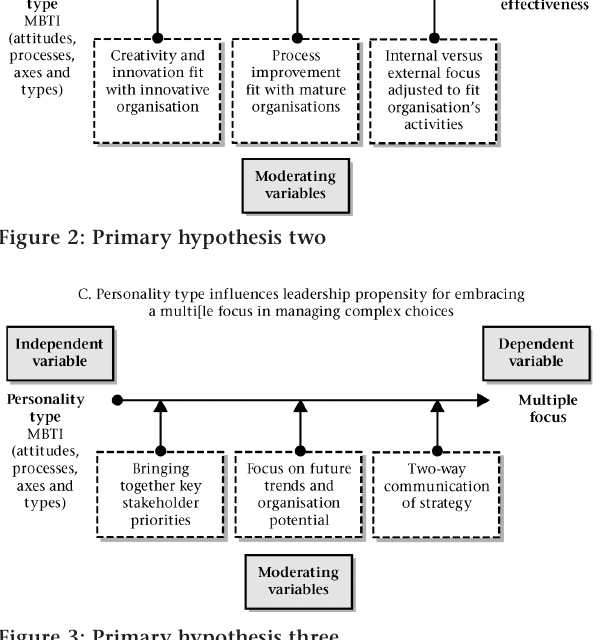
Figure 3: Primary hypothesis